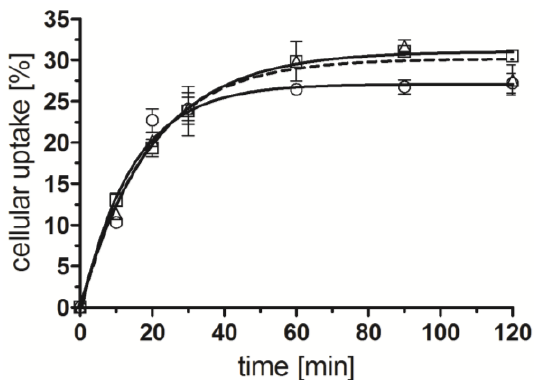
Figure 2. Receptor specific internalization of radiometal conjugates in PC-3 cells, overexpressing GRP-receptor; [ 99m Tc(CO) ( 14 )] (□, continuous line), [ 99m Tc(CO) 3 (∆, dotted line), [ 99m Tc(CO) ( 16 )] (○, continuous line); normalized to 10 6 cells per well; 3 n = 2–3 (in triplicates, reported by means ± SD, calculated by non-linear regression using GraphPad Prism 5.0).